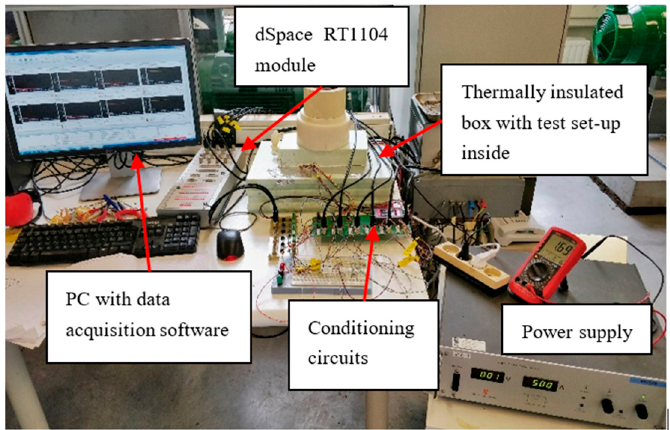
Figure 17. The complete experimental set-up.